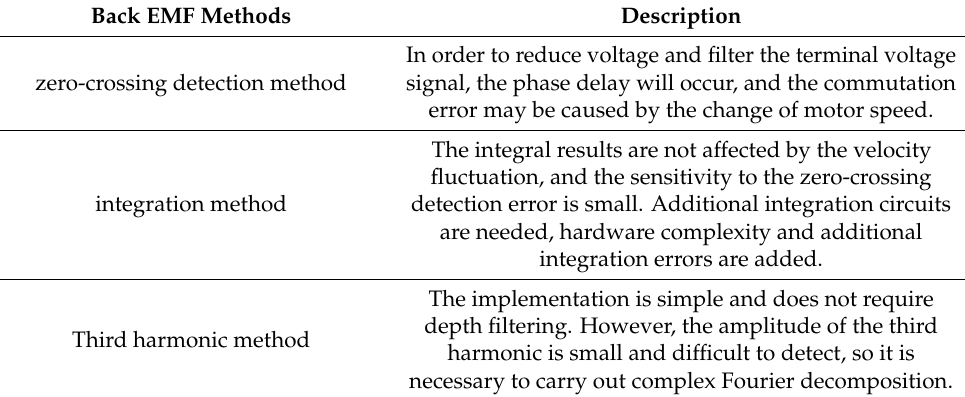
Table 4. Back EMF methods and